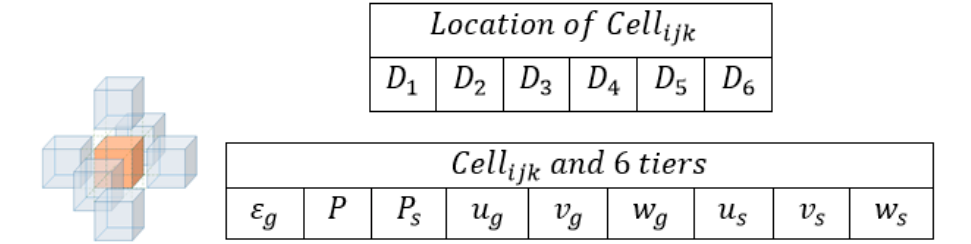
Figure 4. Sixty-nine parameters of artificial neural network (ANN).